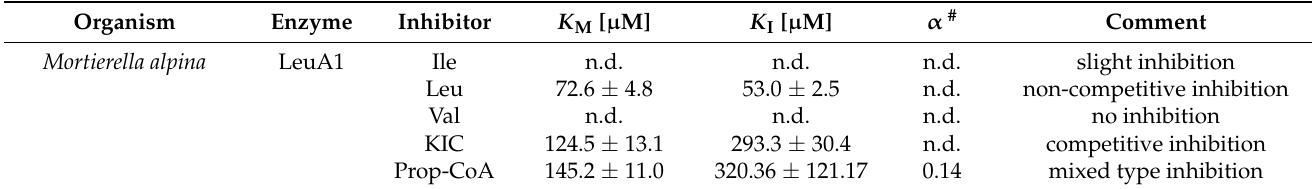
Table 4. Kinetic parameters of LeuA1 inhibitors. Reactions were carried out in the presence of the substrates KIV and Ac-CoA. # α value was determined for mixed type inhibitor Prop-CoA ( α < 1 uncompetitive, α = 1 non-competitive, α > 1